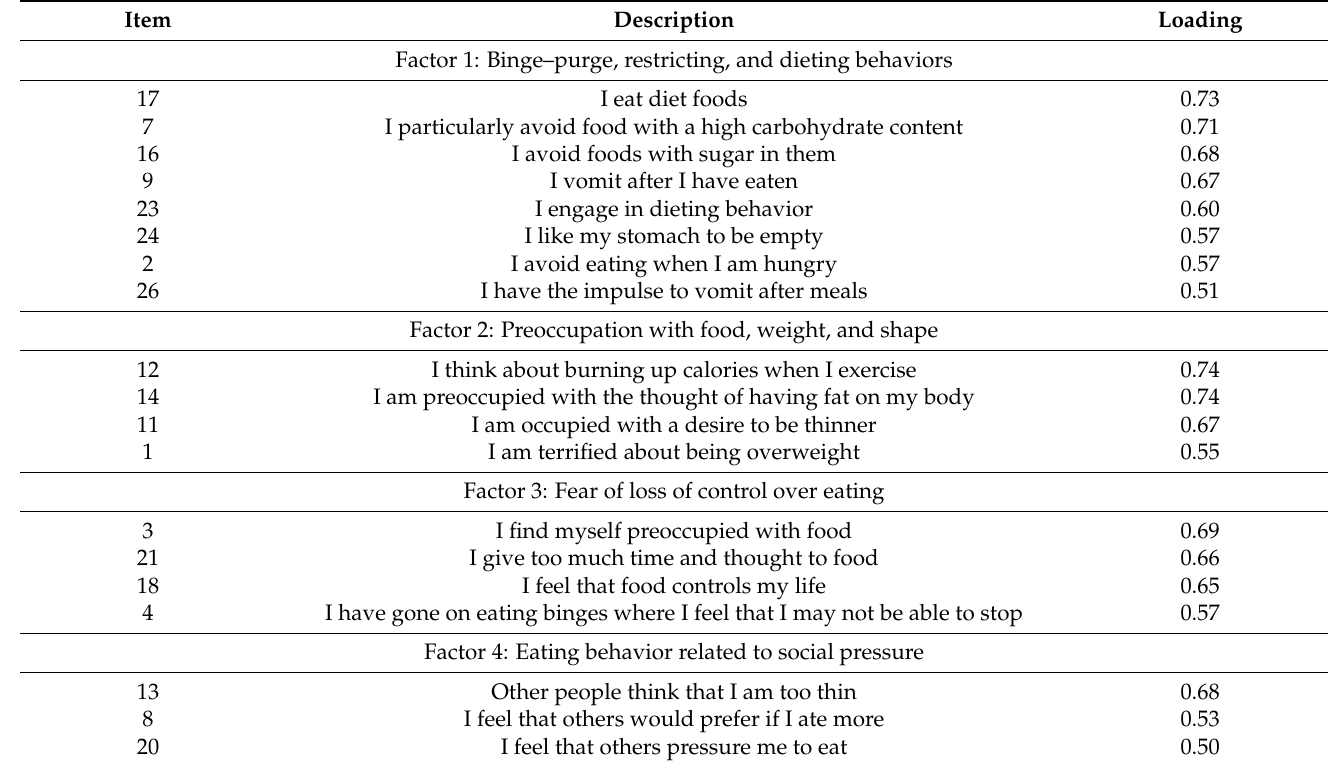
Table 3. EAT-26 factor loadings based on CFA in a nonclinical Arab Muslim sample.